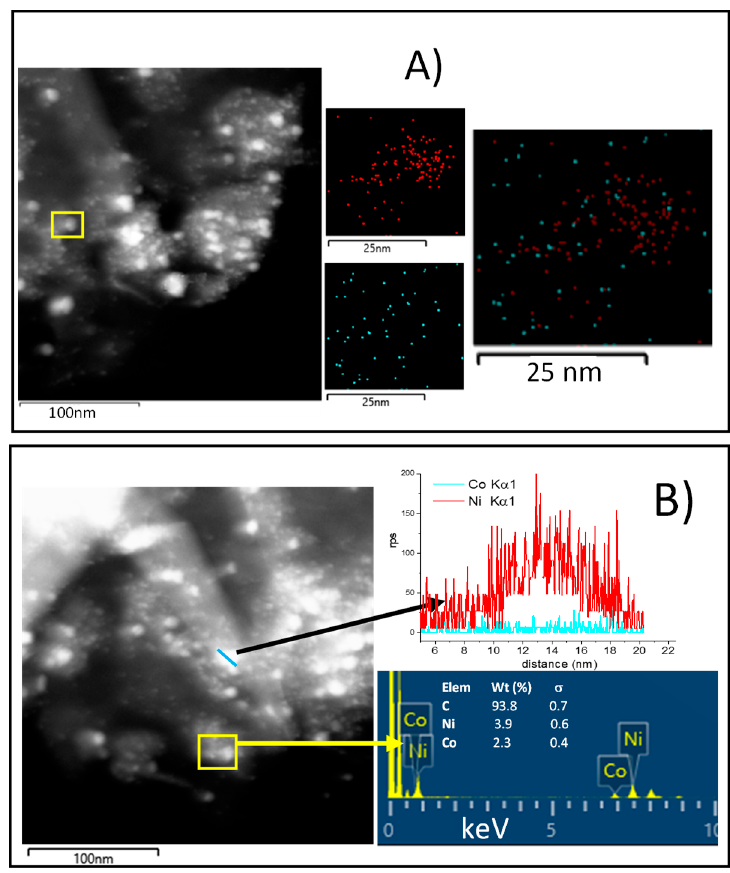
Figure 5. ( A ) Dark-field STEM image of NiCo 1:1 /G with the corresponding EDS elemental maps of the highlighted area showing the chemical distribution of Ni (red), Co (blue); ( B ) EDS line-scanning of NiCo 2:1 /G Ni (red), Co (blue).